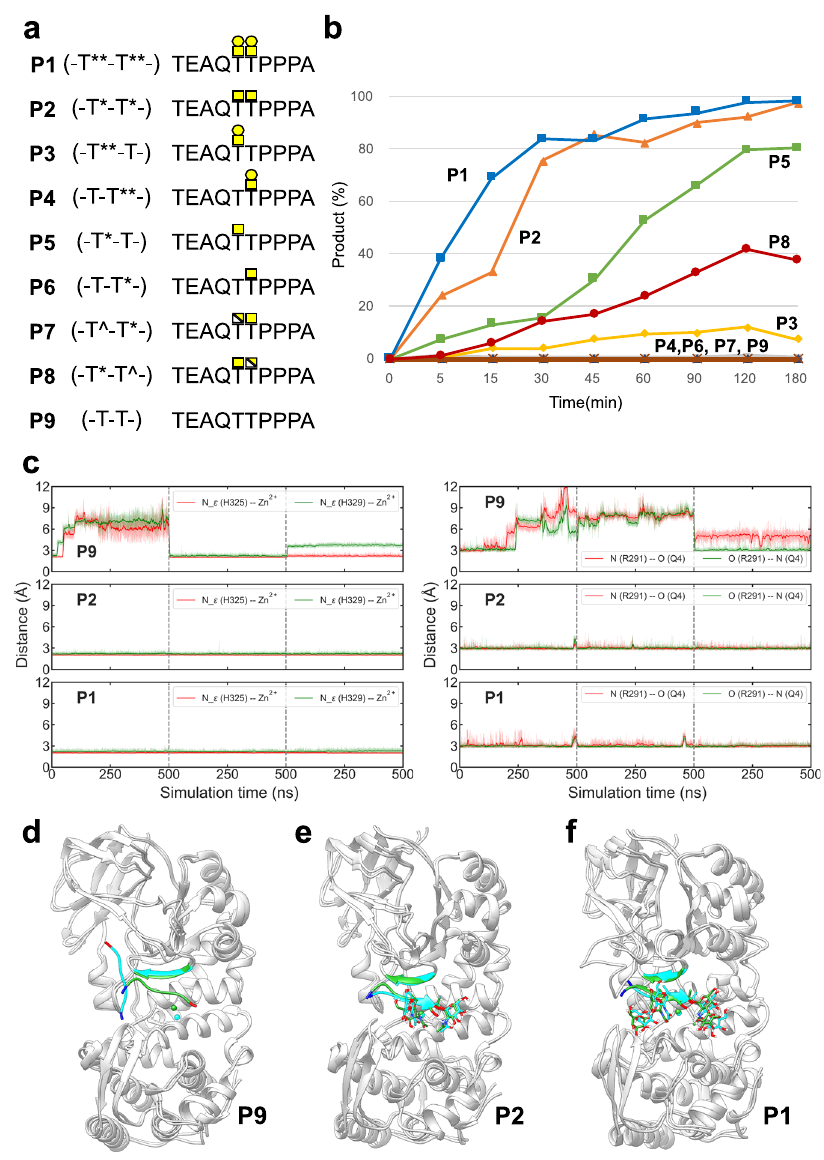
Fig. 4 | Selectivity of wt AM0627 A21-E506 for peptides containing different O -glycanforms.a Schemeofthedifferent(glyco)peptidesusedinthisstudy.Note that both the GalNAc and Gal moieties are indicated as a yellow square and circle, respectively, whereas galactosamine is indicated as a white/yellow square.